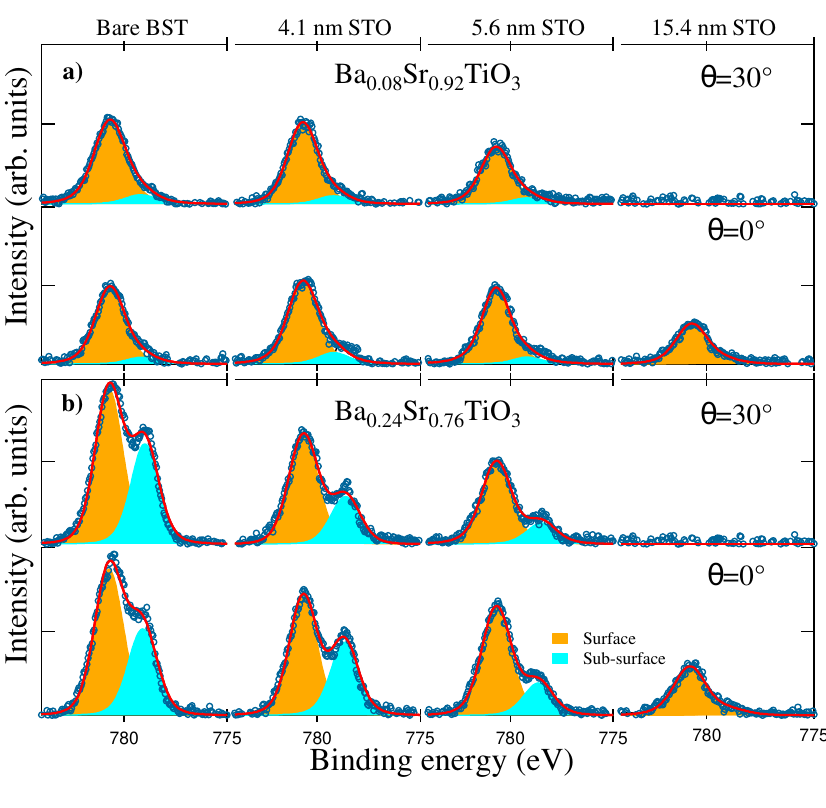
Fig. 3. Ba 3d 5/2 core-level spectra at normal emission (bottom), and 30° (top) emission angles were acquired at four different STO overlayer thicknesses (increases from left to right) at fixed nominal stoichiometry, i.e. (a) BST 0.92 , and (b) BST 0.76